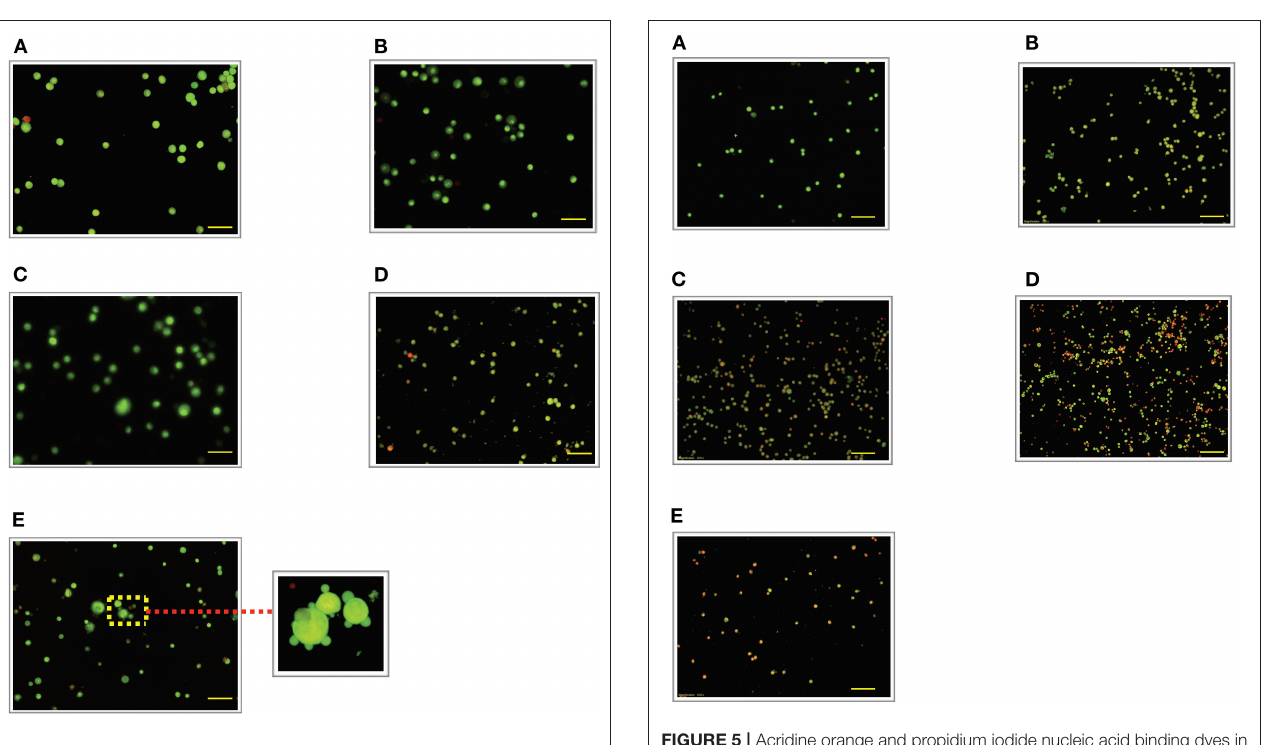
FIGURE 4 | Acridine orange and propidium iodide (AO/PI) nucleic acid binding dyes in LPS-stimulated cells. Cells were stimulated with 3 µ g/mL LPS for (A) . Control, (B) . 12, (C) . 24, (D) . 48, and (E) . 72h. Cells were stained with AO/PI to examine their morphological changes, where the green color represents AO, which stains live and dead nucleated cells while the red color represents PI, which stains dead nucleated cells. Representative fluorescence images from inverted fluorescence microscope. Field of views for each time point from three independent experiments. Purple arrow shows plasma membrane blebbing. Pictomicrographs were taken with original magnification (10 × ); the scale bar represents 100 µ m.